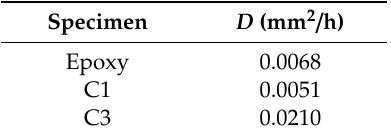
Table 2. Di ff usivities in the through-the-thickness direction, after [49].